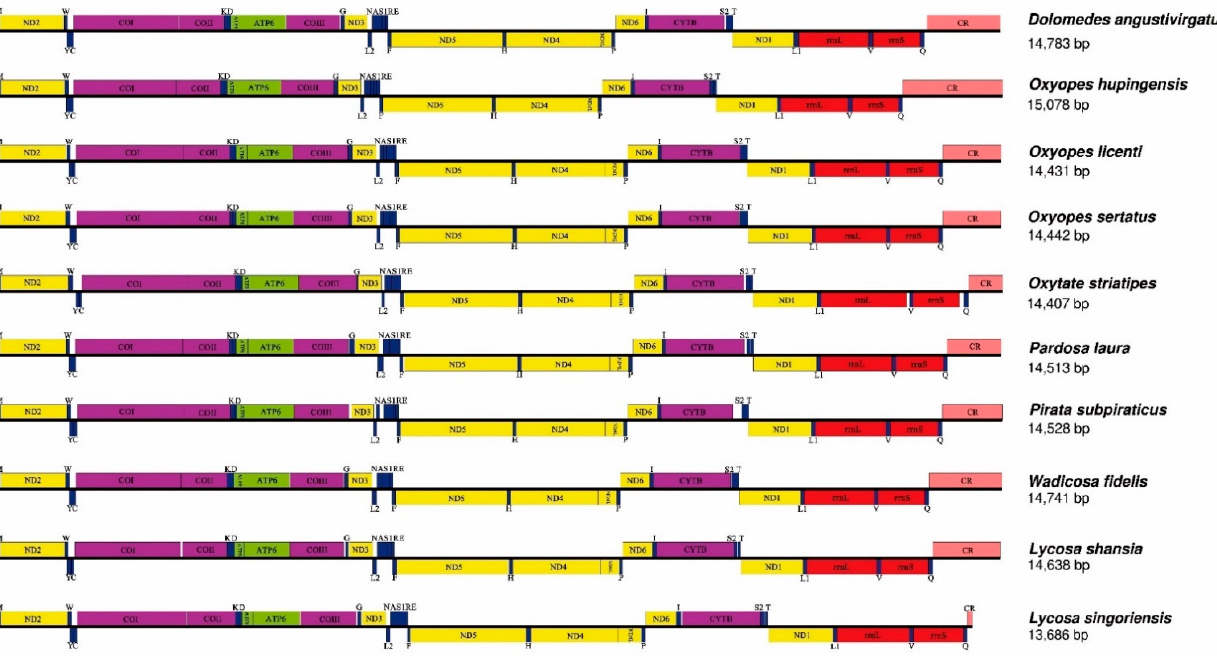
Figure 2. Comparison of mitogenome structure among ten Lycosoidea species. Table 3. Mitochondrial composition of the L. shansia (on the left) and L. Singoriensis (on the right).